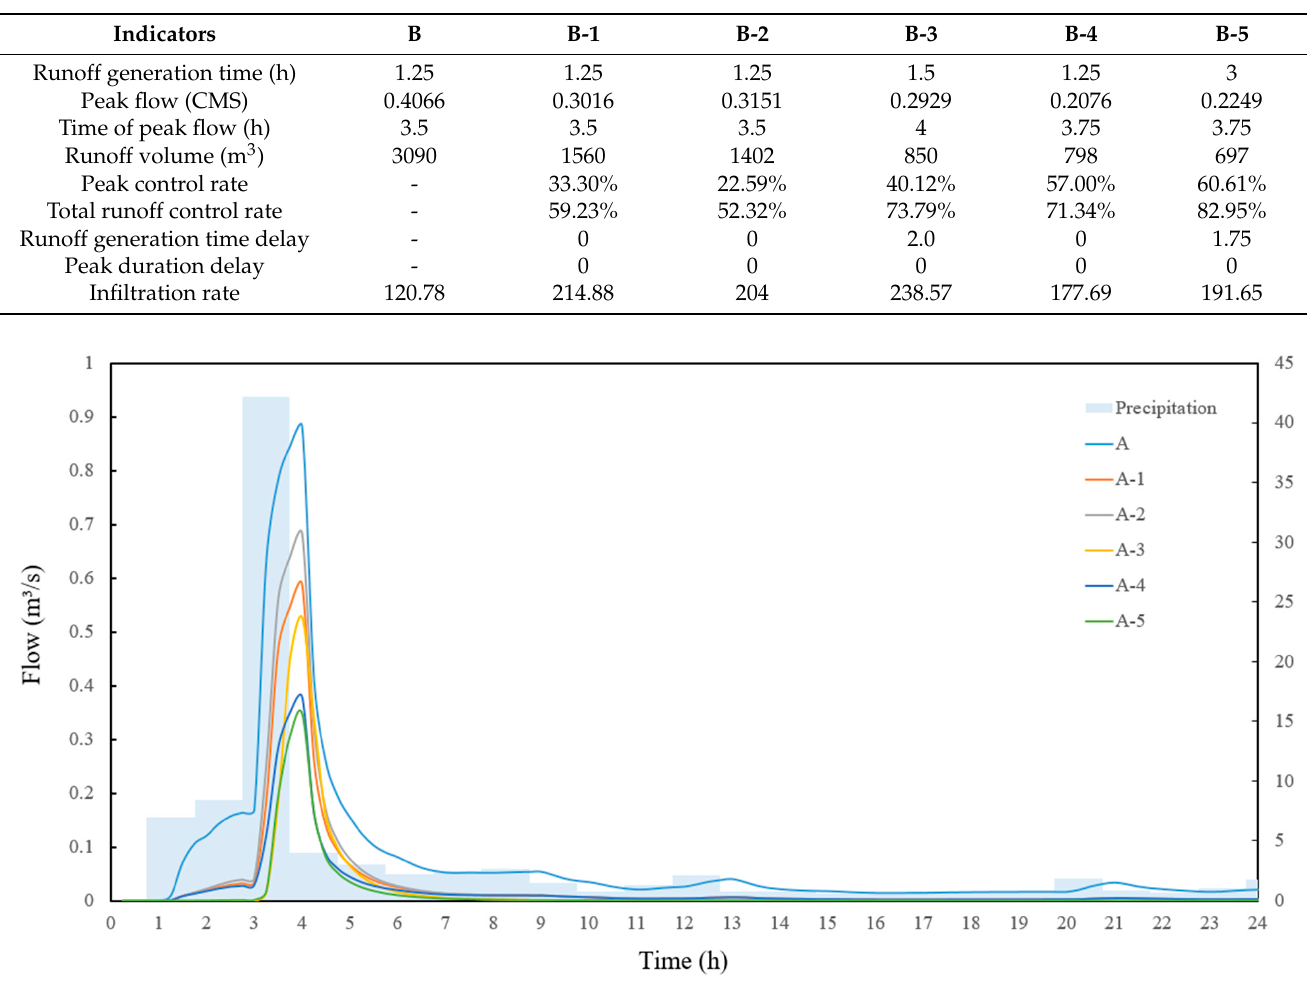
Figure 10. Runoff process in axial mode residential areas under rainfall with a return period of 2 years. 2